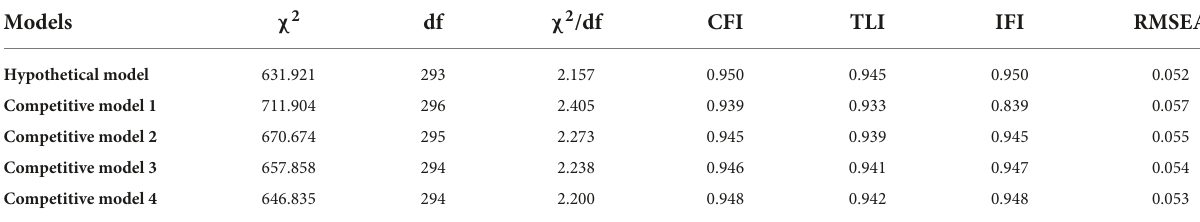
TABLE 4 Model fitness